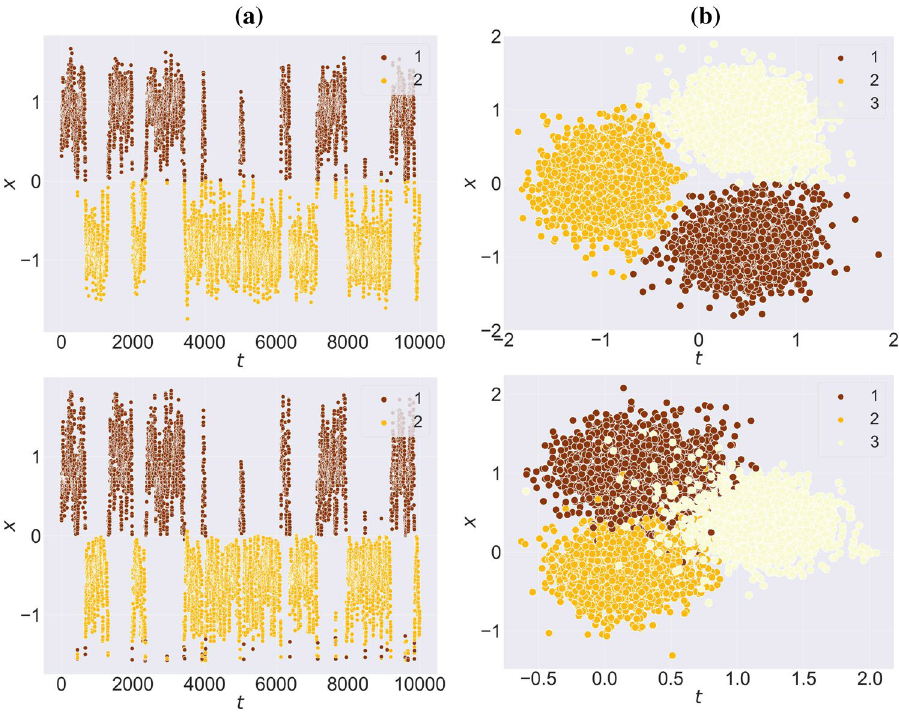
Figure 3. The comparison of an initial trajectory sampled from the SDE (1) ( top ) and the final graph embedding for ( bottom ): ( a ) the npos_2WellGraph dataset and ( b ) for the pos_3WellGraph